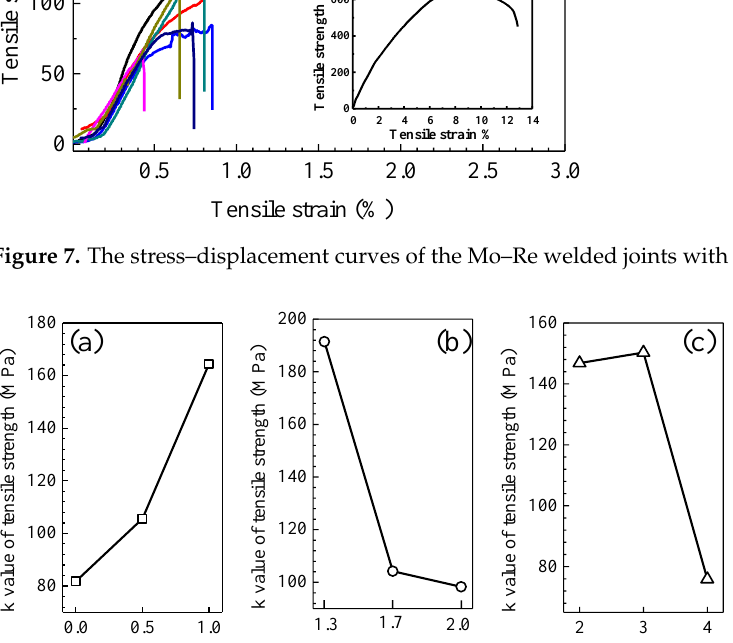
Figure 8. The relationships of ( a ) the defocusing amount, ( b ) power, and ( c ) welding speed with the maximum tensile strengths of the Mo – Re joints with a thickness of 0.5 mm.